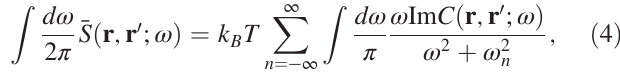
voltage fluctuations of the wire induce excess fluctuating charges on the capacitor. As a result, a force originating from these types of fluctuations is induced between the plates. It is clear that this monopolar charge fluctuations force differs in origin from the dipolar fluctuation force effect. The description of the interaction is closely related to the surface charge density response δσ due to the external voltage δ V via the interaction Hamiltonian